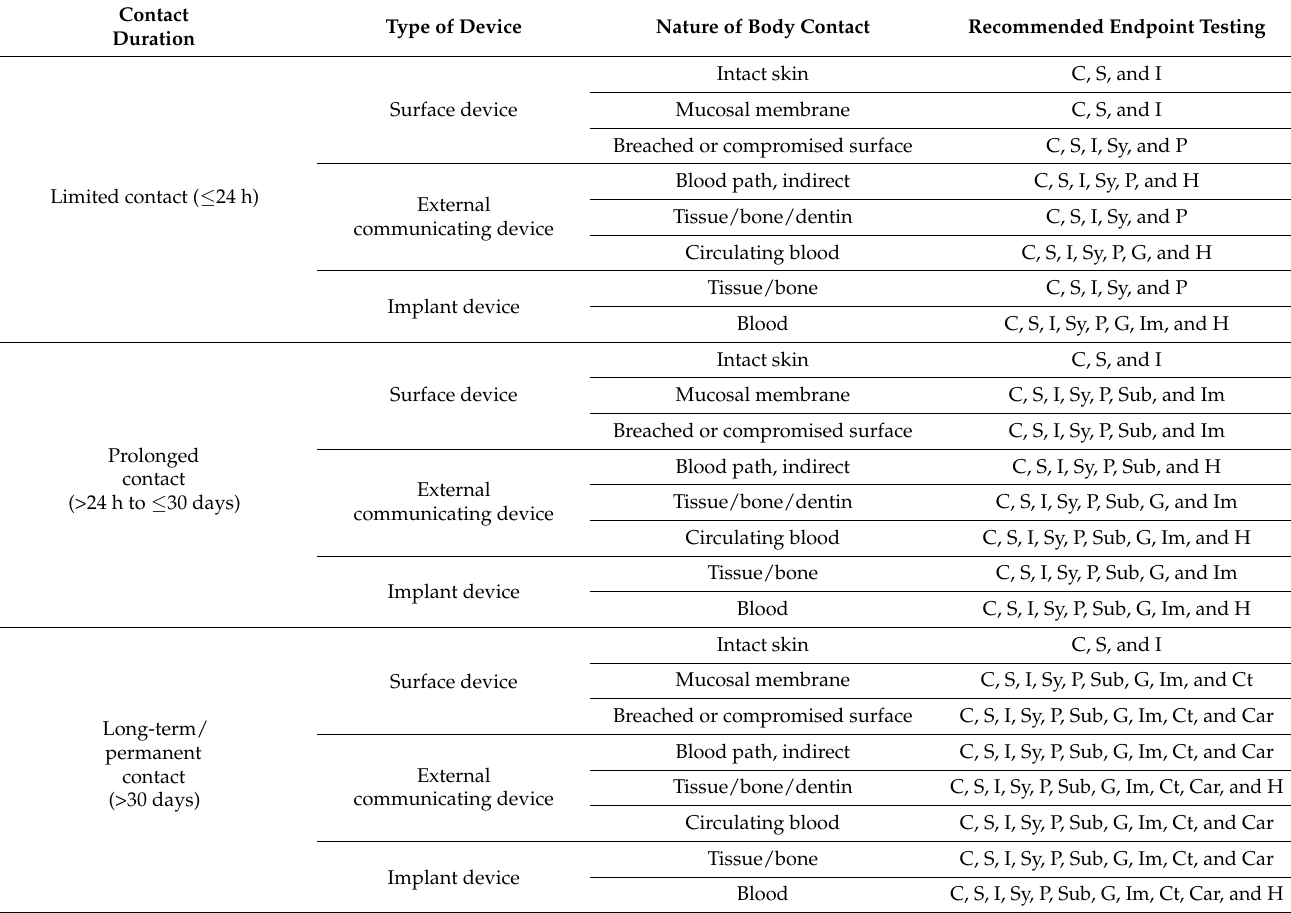
Table 2. FDA framework for the evaluation of biocompatibility in device